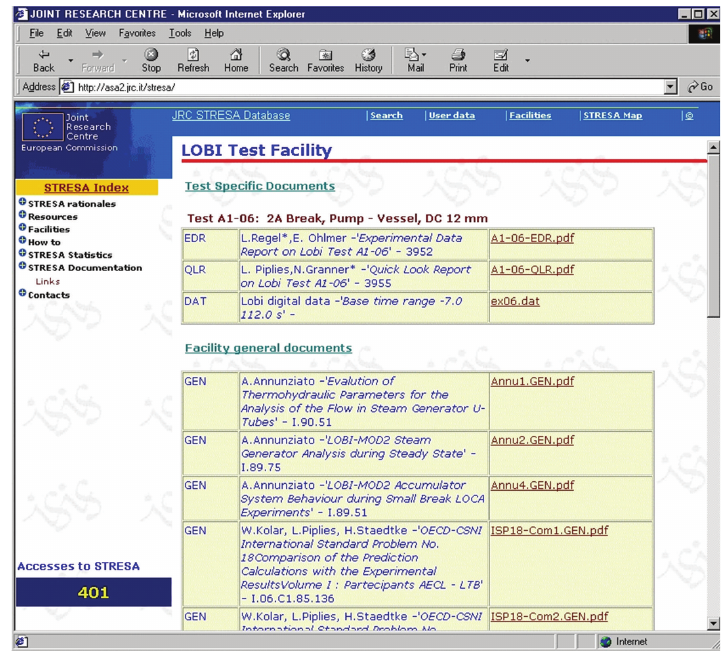
Figure 9: Typical STRESA data set for each LOBI